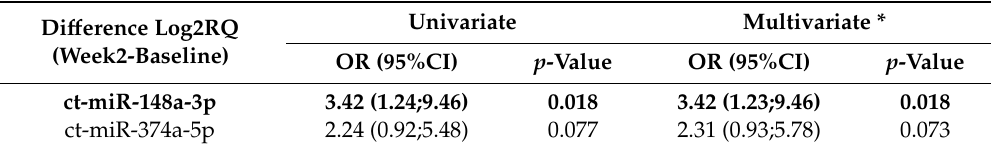
Table 2. Association between changes in ct-miRNA levels and pathological complete response (pCR): univariate and multivariate logistic regression model by considering the Di ff erence Log2RQ (week2-baseline) as continuous